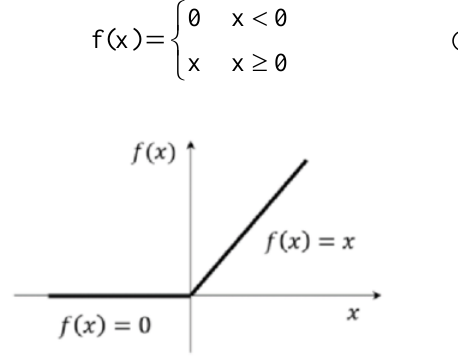
Figure 2. ReLU activation function (Dubey and Jain,